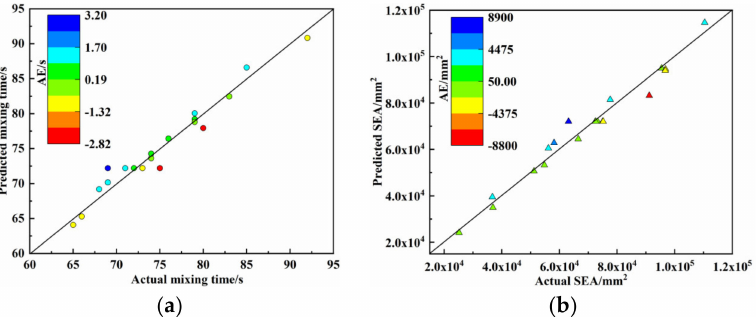
Figure 8. Comparison between actual and predicted values for ( a ) MT and ( b ) SEA .